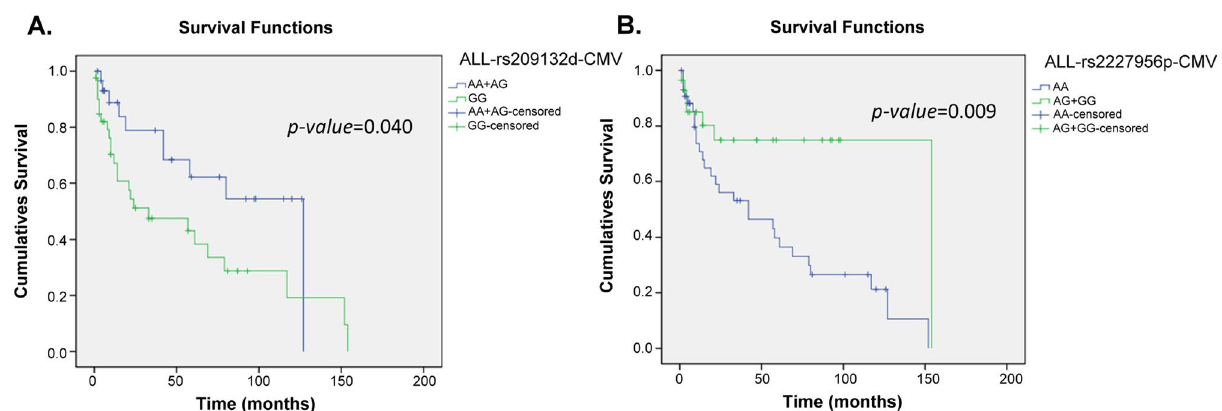
Figure 2. Kaplan–Meier analysis of overall survival curves based on the CMV-related SNPs in ALL patients. ( A ) The rs209132 of TRIM27 in donor group. ( B ) The rs2227956 of HSPA1L in recipient group. censoring: the time point of patient death or losing contact; x-axis: the time from receiving transplantation to death. y-axis: the ratio of surviving